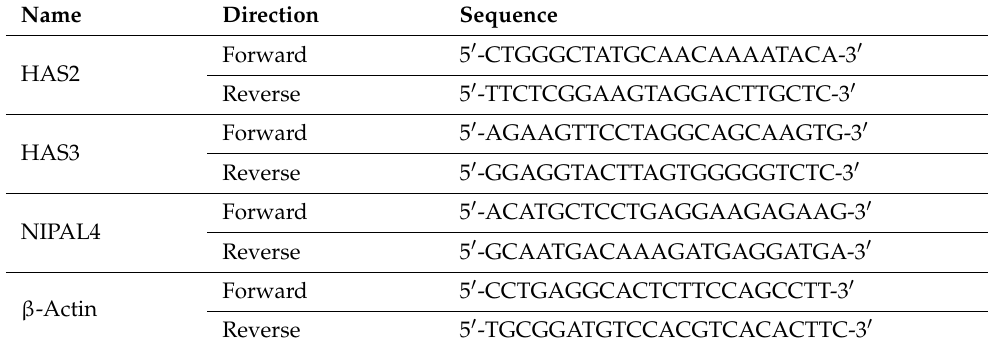
Table 2. Primer pairs for real-time